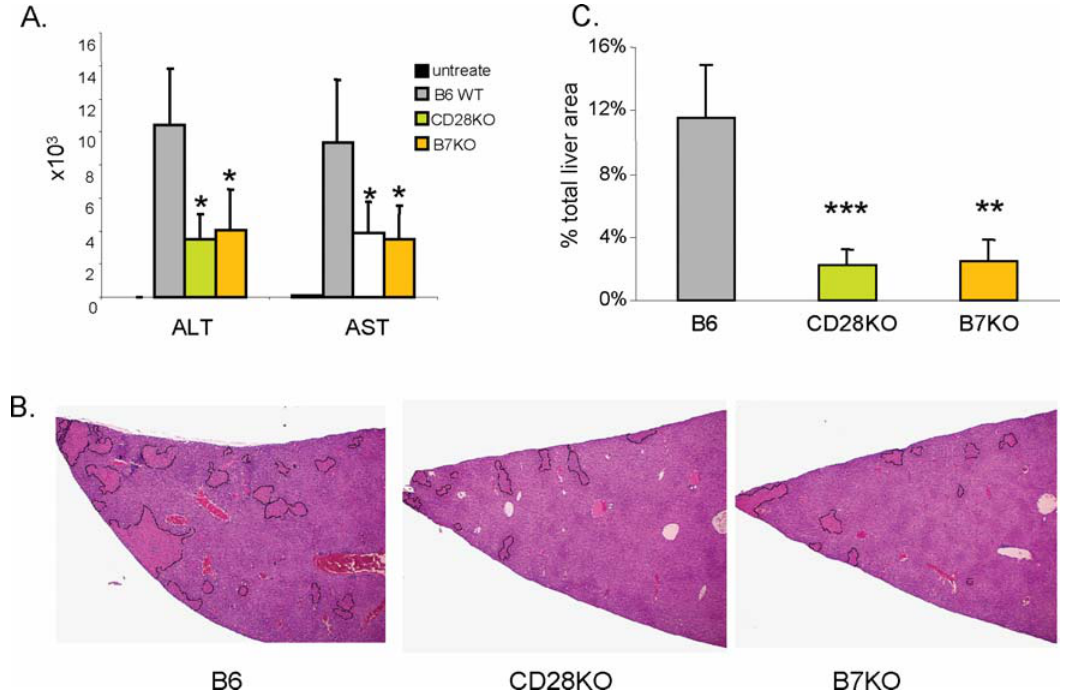
Figure 6. Con A induced hepatitis is alleviated in B7- and CD28- deficient mice. Eight-week old B7KO, CD28KO and C57BL/6 mice received intravenous injection of Con A at a dose of 20 mg/kg. Sixteen hours later, serum and liver tissues from individual mice were harvested. A. Serum ALT and AST levels. B. One representative section from each group showing the pattern of liver injury. C. Average percentages of area with injuries from 3–4 sections per mouse and 4–5 mice per